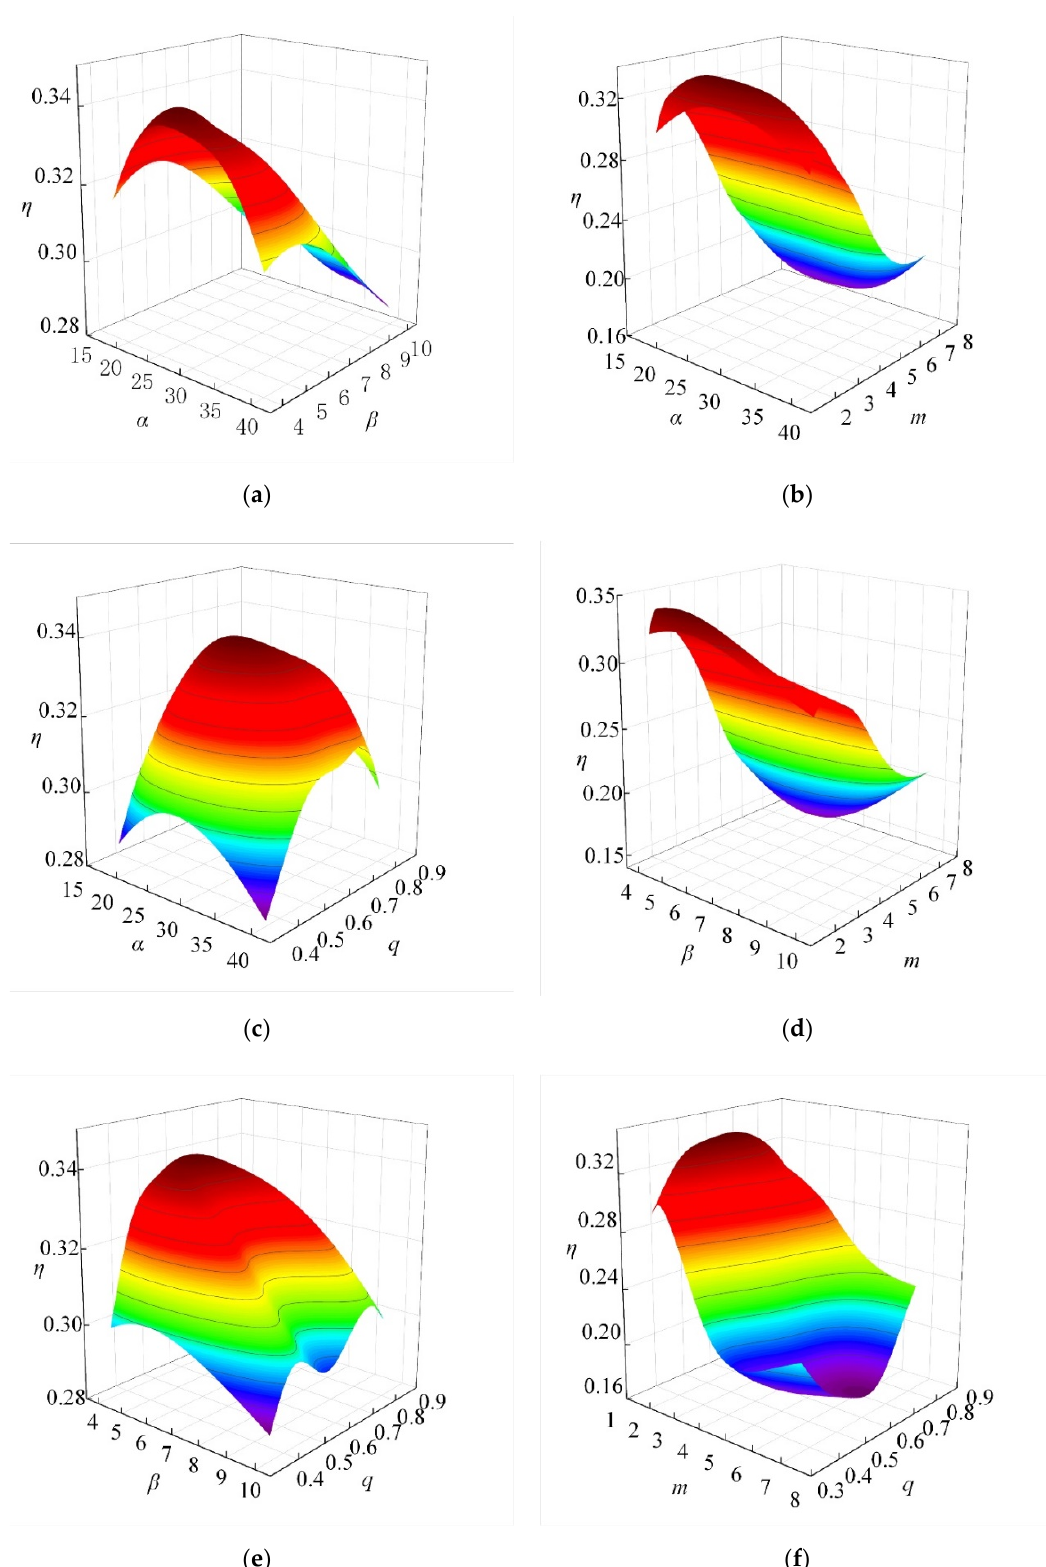
Figure 8. Response surface of efficiency. ( a ) α and β ; ( b ) α and m ; ( c ) α and q ; ( d ) β and m ; ( e ) β and q ; ( f ) m and q .